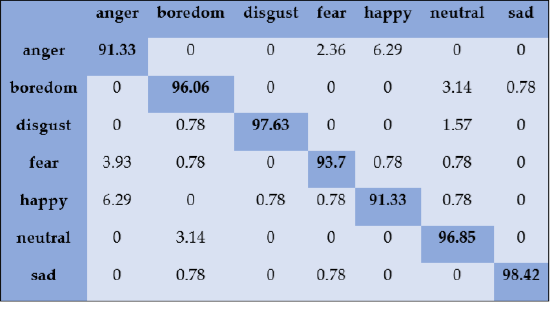
Figure 2. Confusion matrix on Emo-DB dataset for speaker-dependent SER.